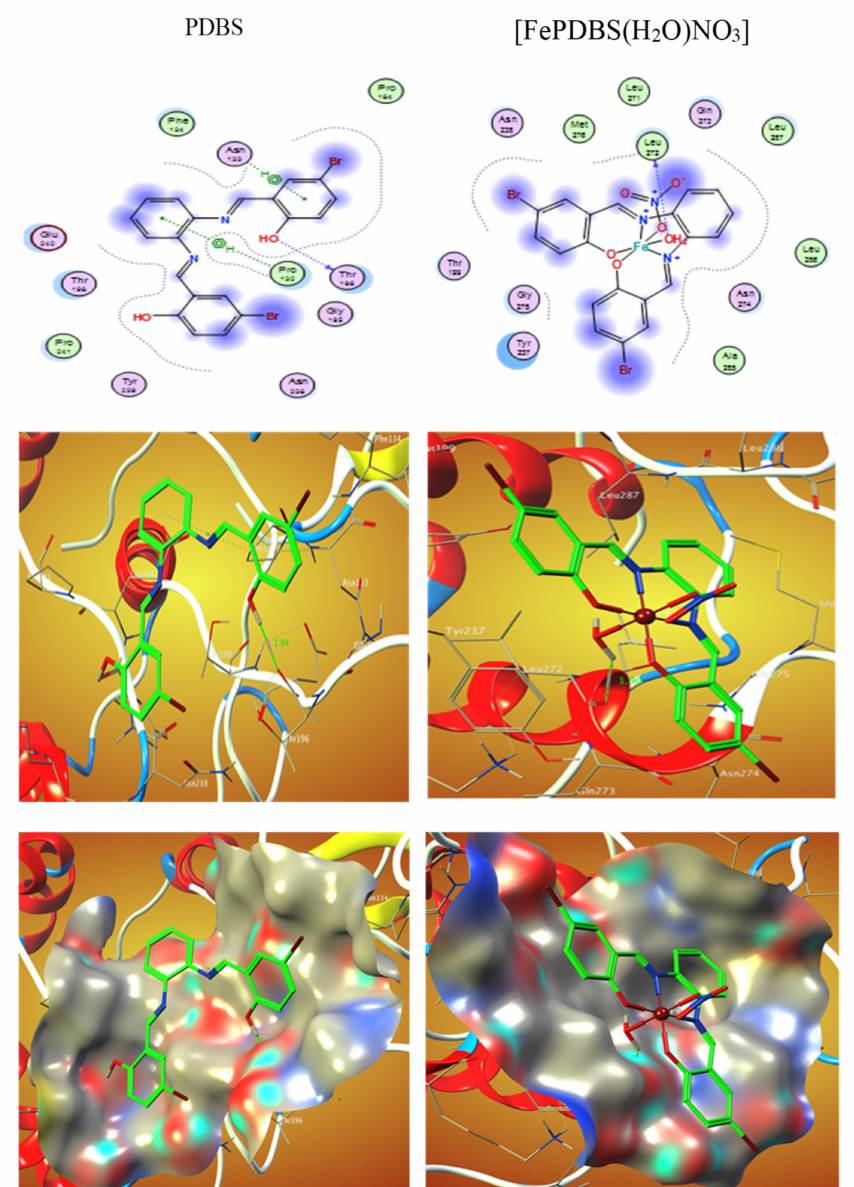
Figure 3. 2D and 3D maps illustrating the interaction of PDBS and (FePDBS (H 2 O) NO 3 ) also with the cell surface of the viral protein receptor (PDB ID: 6lu7). Hydrophobic contacts with amino acids are depicted by dashed